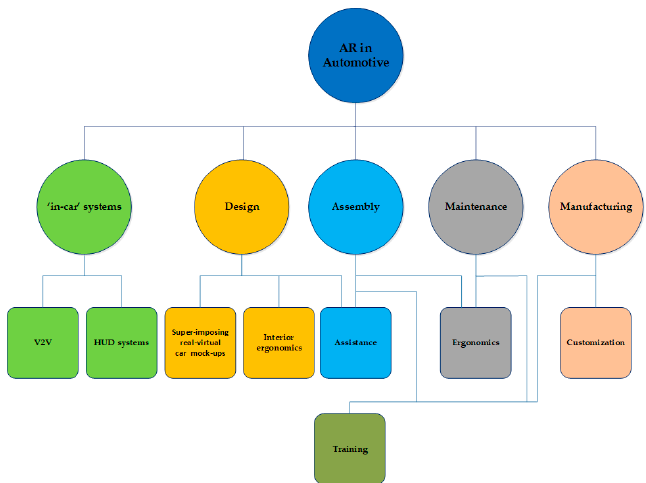
Figure 12. AR applications in automotive.